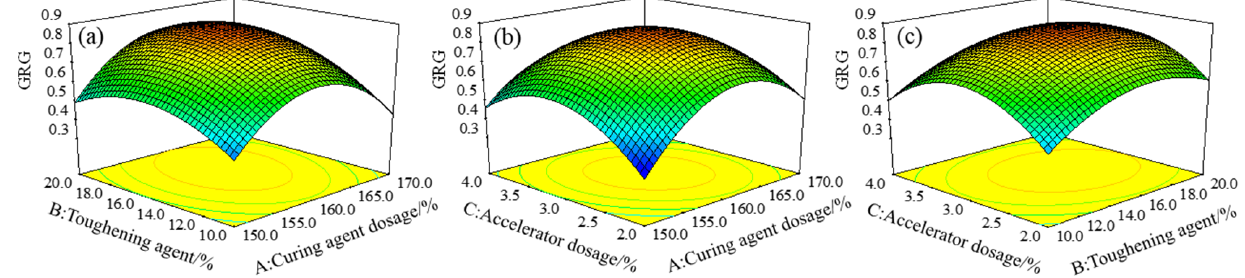
Figure 9. GRG three-dimensional response surface under the interaction of factors ( a ) A and B , ( b ) A and C , and ( c ) C and B .